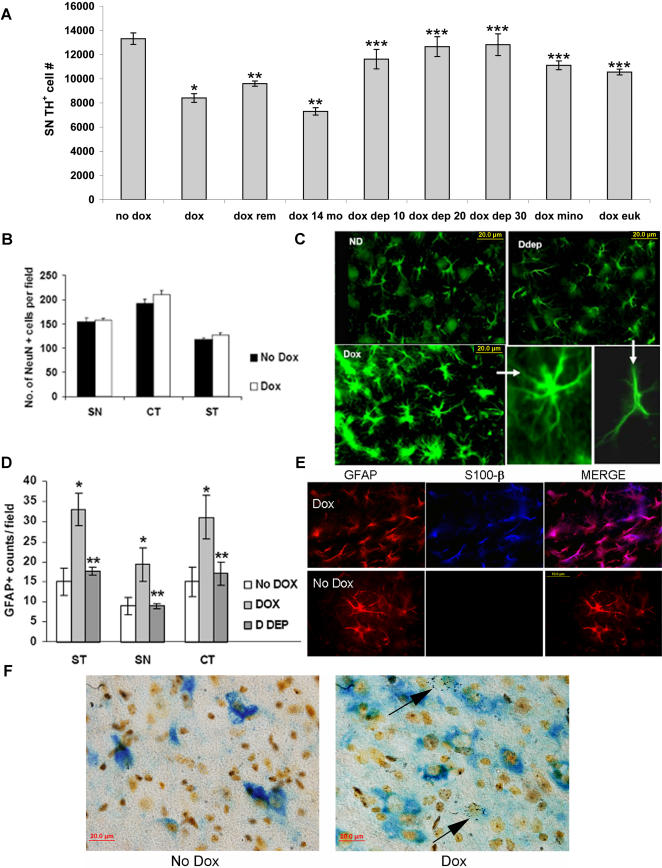
Inducible elevation in astrocytic MAO-B results in selective, age-related SN dopaminergic neurodegeneration and global astrocyte activation even in the absence of neurotoxin. A. TH+ SN cell counts from uninduced transgenics (no dox) versus induced transgenics at 3-4 months (dox) , following dox removal (dox rem) at 14 months of age (dox 14 mo), and induced co-treated with deprenyl at 10-30 mg/kg (dox dep 10-30), the anti-inflammatory agent minocycline at 10 mg/kg (dox mino) or the anti-oxidant Euk189 at 10 mg/kg in young animals.Data is expressed as total number of SN TH+ cells numbers per animal; *p<0.01 compared to ND, ** p< 0.05 compared to Dox, and *** p< 0.05 compared to dox. B. Neuronal (NeuN+) counts from uninduced (No Dox, filled bars) versus dox-induced transgenics (Dox, open bars) performed in equivalent nigral (SN), cortical (CT), and striatal (ST) tissue sections. Values represent average cell numbers per field in three separate fields per section, three sections per animal. N = 5 animals per group. C. Representative micrographs demonstrating cortical astrocytic activation in dox-induced (Dox) versus uninduced (ND) animals and dox-induced animals co-treated with deprenyl (Ddep). Astrocytes from induced transgenics displayed enhanced GFAP staining and increased branching indicative of astrocyte activation (higher magnification in lower middle panel); deprenyl treatment resulted in reduced branching similar to that observed in uninduced controls (higher magnification in lower right-hand panel). D. Astrocytic (GFAP+) counts from uninduced (No DOX, open bars) versus dox-induced transgenics (DOX, light grey bars) and mice dox-induced in the presence of deprenyl co-treatment (D DEP, dark grey bars) performed in equivalent striatal (ST), nigral (SN), and cortical (CT) tissue sections. Values represent average cell numbers per field at 40×magnification in three separate fields per section, three sections per animal. N = 5 animals per group; *p>0.05, ** p<0.1. E. Representative micrograph demonstrating increased expression of the astrocytic activation marker S-100β (blue) in GFAP+ cells in the transgenic cortex following dox induction. GFAP-labeled astrocytes (red) in induced animals display increased S-100β staining (pink) versus uninduced. F. Neurodegeneration of TH+ cells as assessed by silver staining. SN sections from uninduced (No Dox) and induced (Dox) animals were processed for TH+ immunoreactivity visualized by alkaline peroxidase (blue) and further processed for silver staining. A black punctate staining was observed in and around dying TH+ neurons (arrows) in Dox but not No Dox fields.